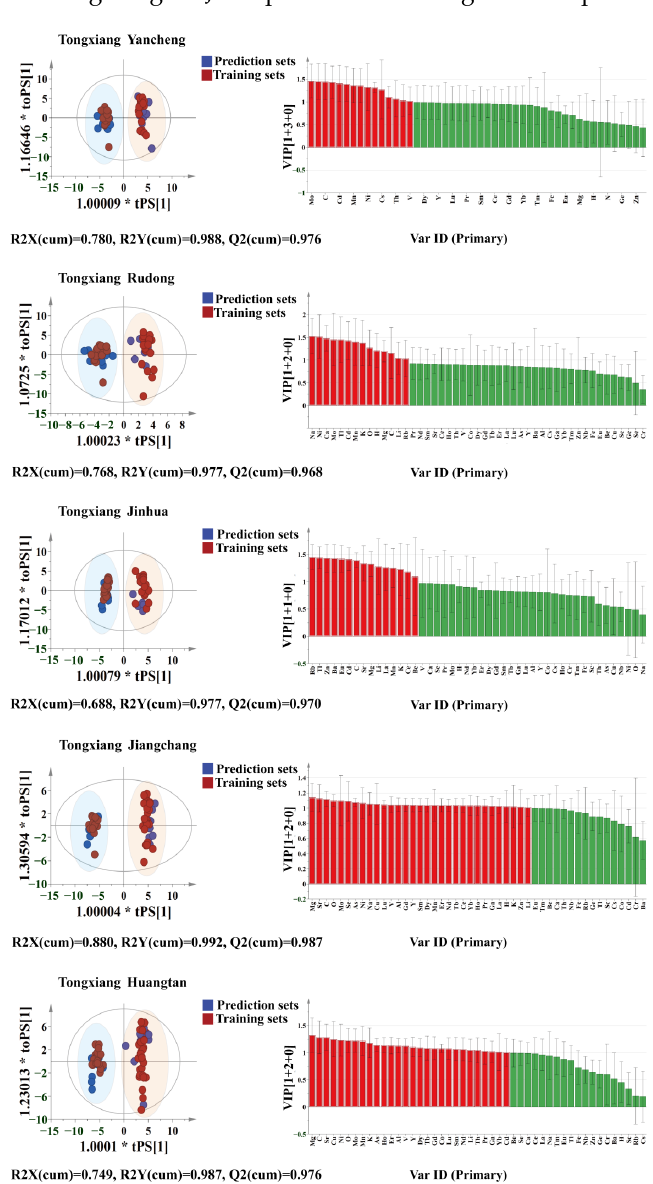
Figure 5. The OPLS-DA score plot (left) and VIP scores (right) were scored for the isotope ratios and element concentrations (48 elements) of the HBJ samples. Samples from different origins are displayed in pairs. In the score plot, blue dots represent the prediction group and red dots represent the model group. Red columns indicate VIP ≥ 1, while green ones indicate VIP <